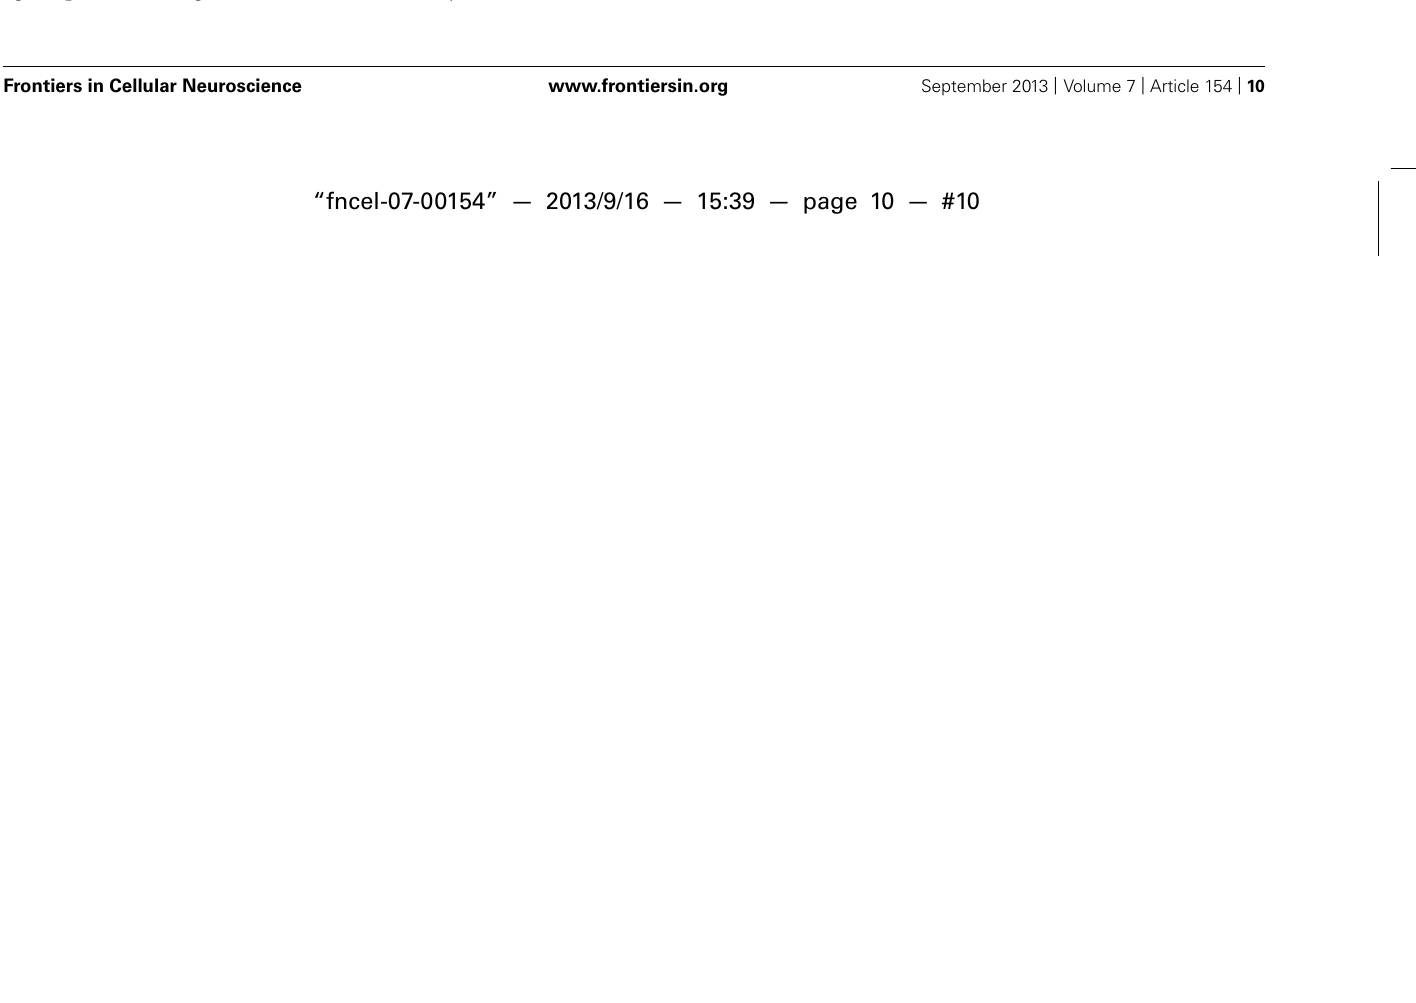
cyclic nucleotide (HCN) or KCNQ channels (Wang et al., 2011), age-dependent changes in a control of inhibitory activities